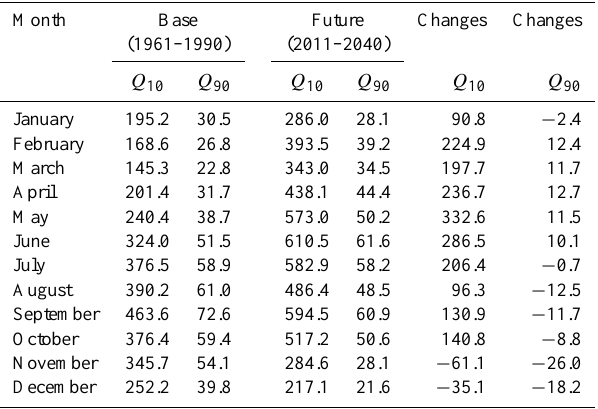
Table 5. Limits and ranges of the confidence interval of flows (m 3 s − 1 ) with a permanence of 10% ( Q 10 ) during the base period (1961–1990) and future period (2011–2040), Santo Ângelo gauge station.